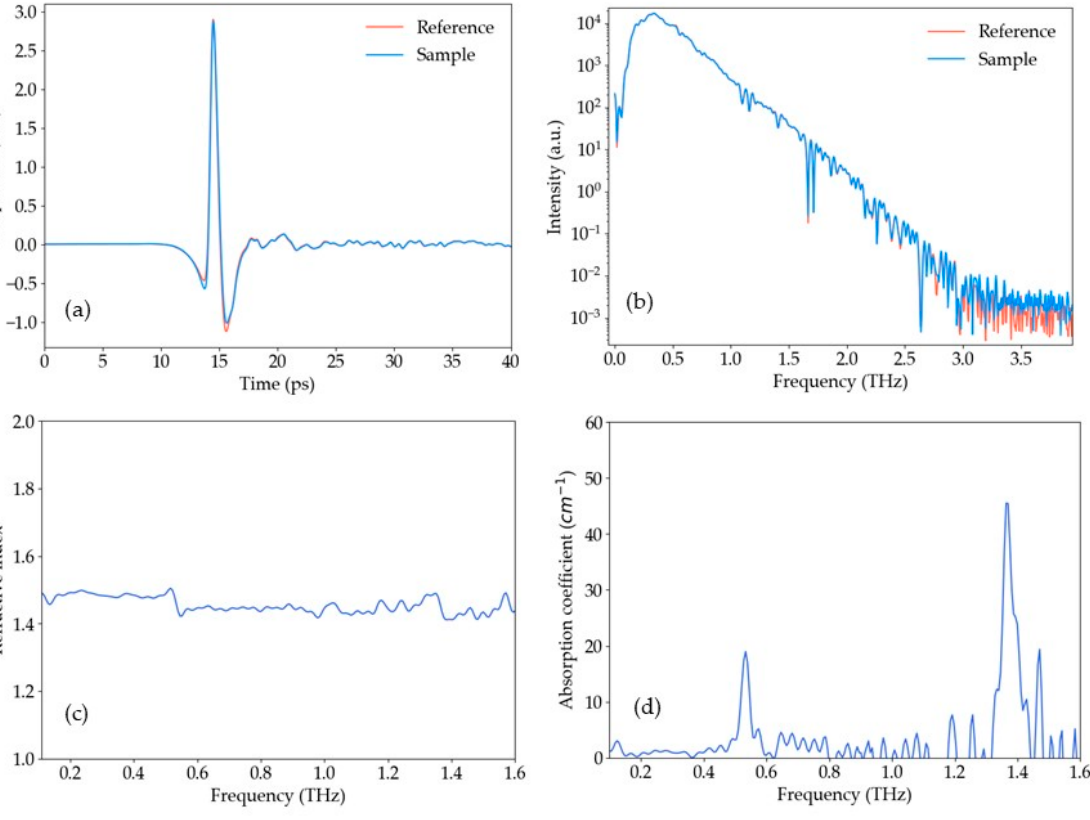
Figure 4. ( a ) The THz time domain reference and sample pulses, ( b ) their respective intensity spectra, ( c ) refractive index, ( d ) absorption coefficient of lactose sample.